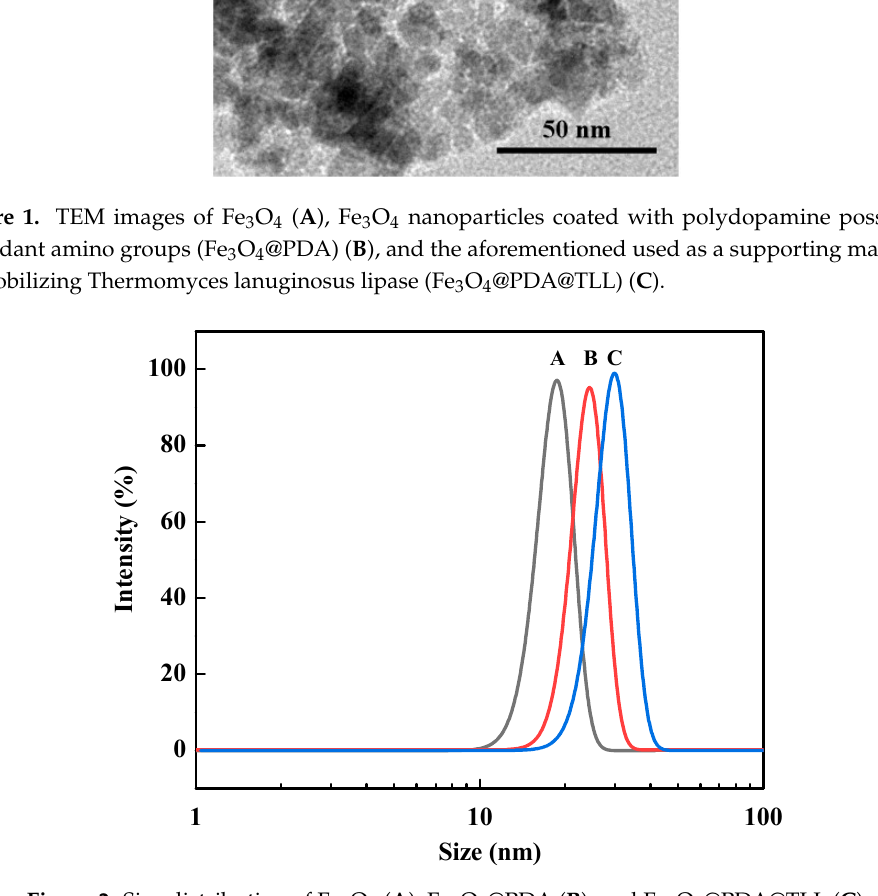
Figure 2. Size distribution of Fe 3 O 4 ( A ), Fe 3 O 4 @PDA ( B ), and Fe 3 O 4 @PDA@TLL ( C ).